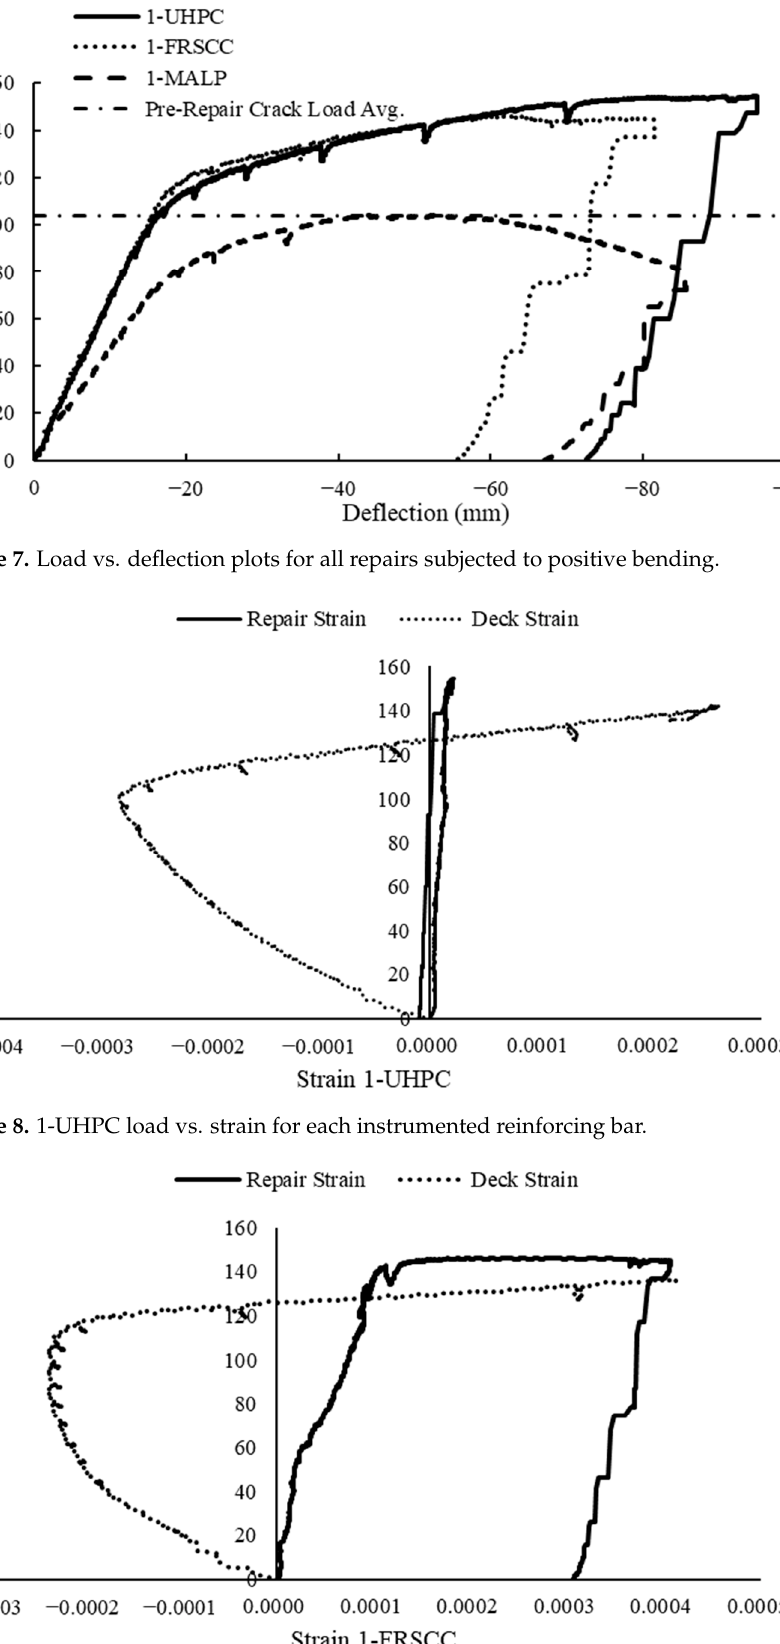
Figure 10. 1-MALP load vs. strain for each instrumented reinforcing bar. The girder joint repairs using the UHPC and FRSCC re-established load carrying ca- pacity beyond the original failure load. Both repaired girders exhibited near-identical re- sponses up to the point of the average pre-repair cracking load. This included a linear response up to a yielding load, where the stiffness was reduced (see Figure 7). The overall behavior appears to mimic the conventional reinforced beam bending response, except there is no low-load stiffness change caused by crack initiation in a pristine beam. This could be due to the pre-cracked nature of the repaired specimen and the fiber reinforce- ment of both repair materials precluding the formation of large, traditional flexural cracks. Conversely, the MALP repair exhibited a softening behavior and did not reach the pre- repair cracking load (see Figure 7). The better stiffness response appears to indicate load transfer to the UHPC and FRSCC repairs. However, the low strain values in the repair reinforcing bars implies that the additional load carrying capacity was mostly developed by the fibers in the repair materials. This would explain why the UHPC reached a higher peak load than the FRSCC, since the UHPC uses steel fibers, compared to polypropylene fibers in the FRSCC, providing both higher bending strength and ductility for the UHPC.